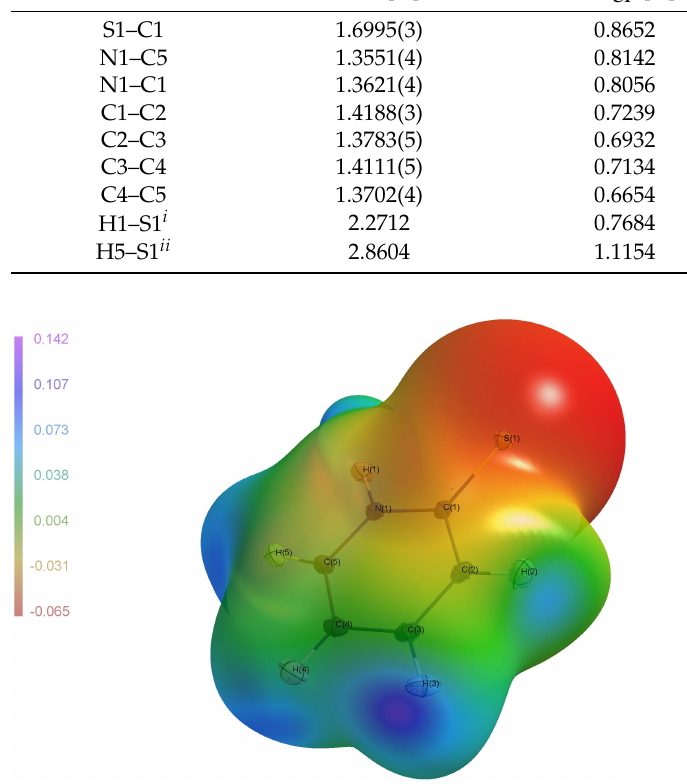
Figure 10. Isosurface of the electron density at 0.001 au. Mapped on this surface is the electrostatic potential. For the meaning of the colours, see the legend in the inset. Three-dimensional grids were calculated with the module XDPROP in XD [36]. The plot was prepared with MoleCoolQt